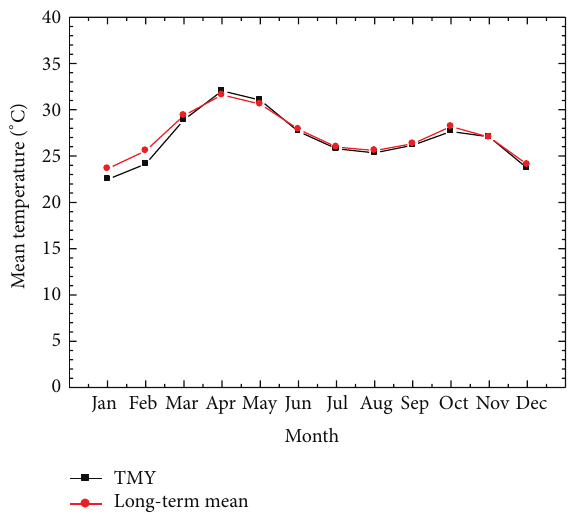
Figure 3: Predicted TMY with long-term average values for the mean temperature.